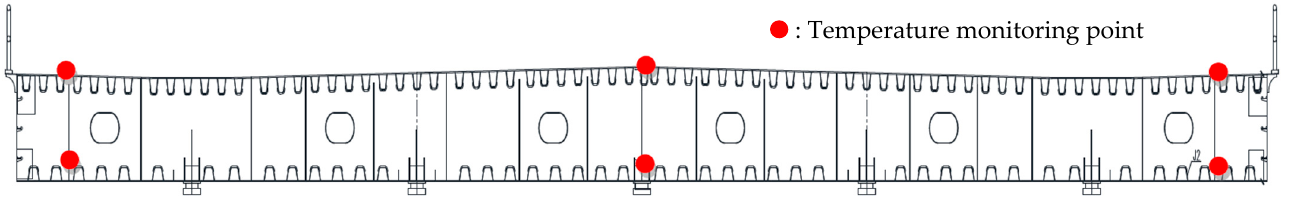
Figure 9. Temperature monitoring points of the box girder (T1 to T5).